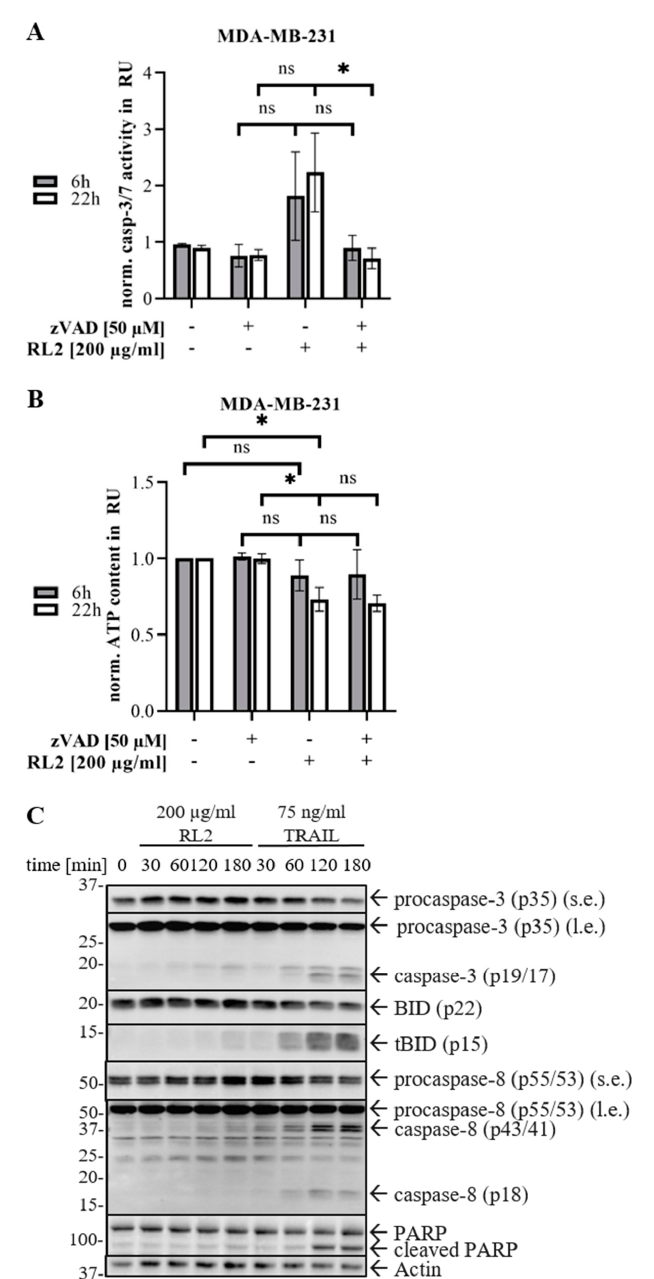
Figure 3. RL2 induces marginal caspase-3 activity and BID processing. ( A,B ) MDA-MB-231 cells were pre-treated for one hour with 50 µM pan-caspase inhibitor zVAD-fmk and stimulated with 200 µg/mL RL2 as indicated. ( A ) Caspase-3/-7-activity was determined by Caspase-Glo3/7 ® Assay. Means and standard deviations of caspase activity are shown in relative units (RU) for three independent experiments and statistically analyzed by paired student t-test. ( B ) ATP levels were measured using the Cell Titer-Glo ® -Luminescent Cell Viability Assay. Mean and standard deviation are shown for three independent experiments. The statistical analysis was carried out by paired student t -test. ( C ) MDA-MB-231 cells were stimulated with 200 µ g / mL RL2 or 75 ng / mL TRAIL (positive control) for indicated periods of time, and subjected to Western Blot analysis with the indicated antibodies. One representative Western Blot out of three independent experiments along with its quantification is shown in Figure S2. ns (not significant; p > 0.05), * (significant; p <